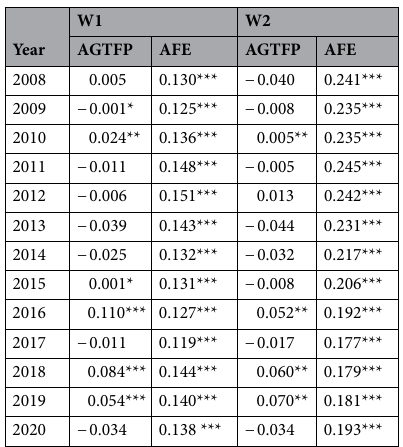
Table 3. The global Maran index under W1 and W2. *, **, *** indicate significance at the 10%, 5% and 1% level. For the estimated coefficients, the standard errors are in parentheses.